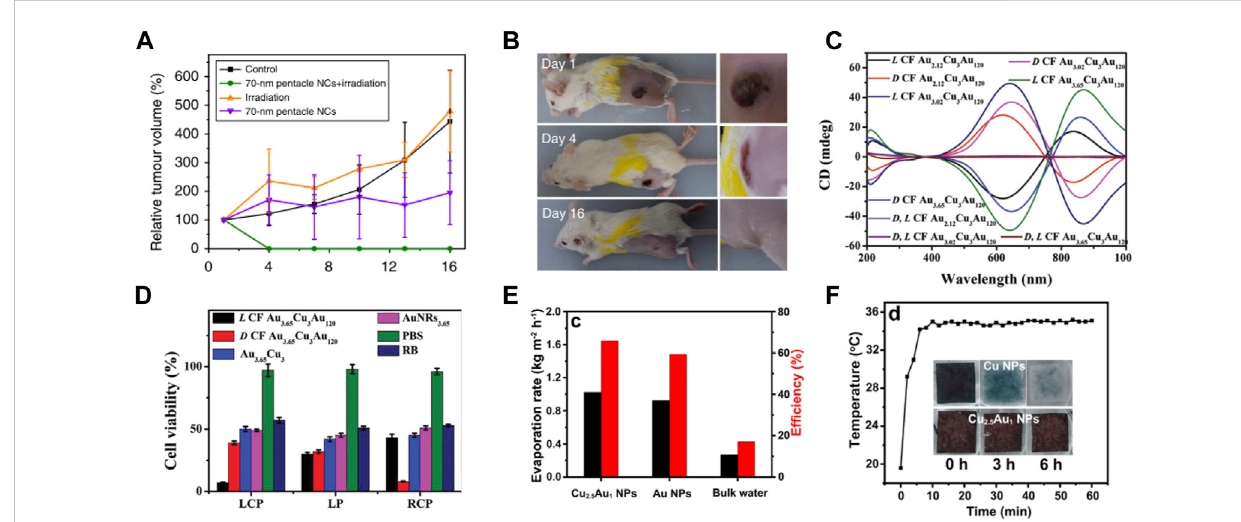
FIGURE 6 (A,B) Characterizationofmousetumorgrowthaftertreatment(Heetal.,2014). (A) Tumorgrowthcurvesofdifferentgroupsofmiceaftertreatment. (B) Photographs of tumor-bearing mice at 1, 4 and 16 days after Au – Cu nanoparticle injection and irradiation in the 808 nm laser group. (C,D) CD and photothermal therapy properties of chiral Au – Cu – Au HNRs (Wang J. et al., 2020). (C) CD spectrum for different AuCuAu HNRs. (D) HeLa cell viability analysis after 808 nm left-circularly polarized, linear polarized and right-circularly polarized light irradiation of HeLa tumor-bearing mice after injection with L CF Au 3.65 – Cu 3 – Au 120 HNRs. (E – F) Characterization of photothermal conversion properties and stability of Cu 2.5 – Au 1 core-shell nanoparticles (Wang Y. et al., 2021). (E) The rates of solar evaporation and solar steam ef fi ciency of Cu 2.5 – Au 1 core-shell nanoparticles, Au nanoparticles, and bulk water under 1 sun illumination. (F) Time-dependent surface temperature curves of Cu 2.5 − Au 1 nanoparticles placed on a saturated CO 2 aqueous solutionandilluminatedby1sun.Insetsin (F) showthephotographsofCu 2.5 − Au 1 nanoparticlesandCunanoparticles placedonasaturatedCO 2 solution with